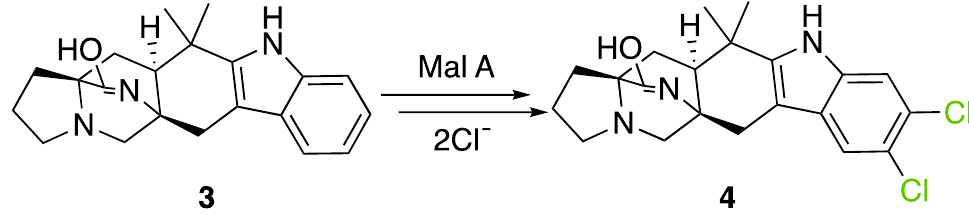
Figure 11. Premalbrancheamide ( 3 ) chlorination by MalA to obtain malbrancheamide ( 4 ). Fungal FDHs Halogenating Phenol Structures